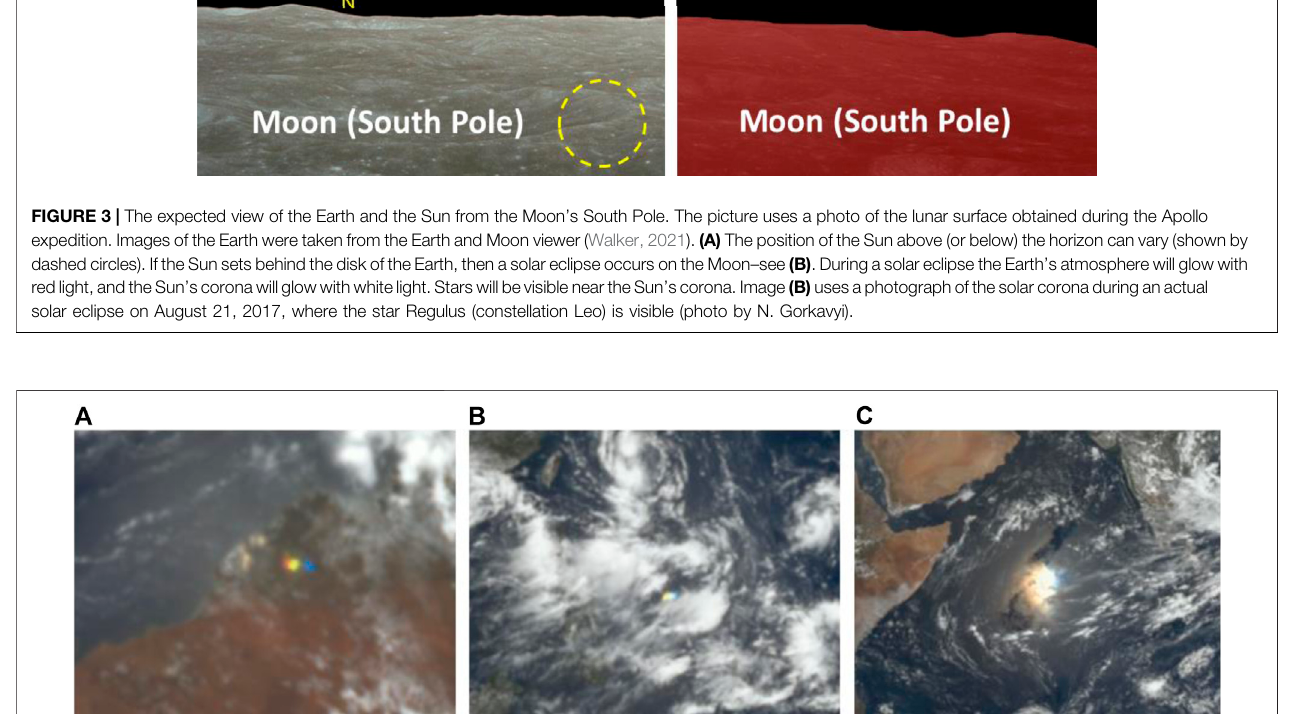
Frontiers in Remote Sensing |